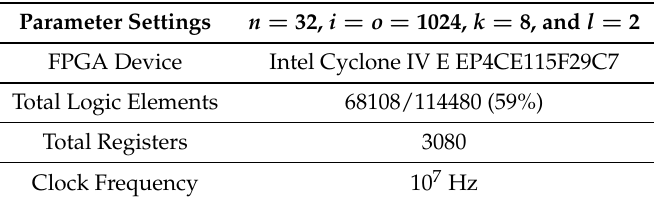
Table 4. Statistics of the FPGA implementation.